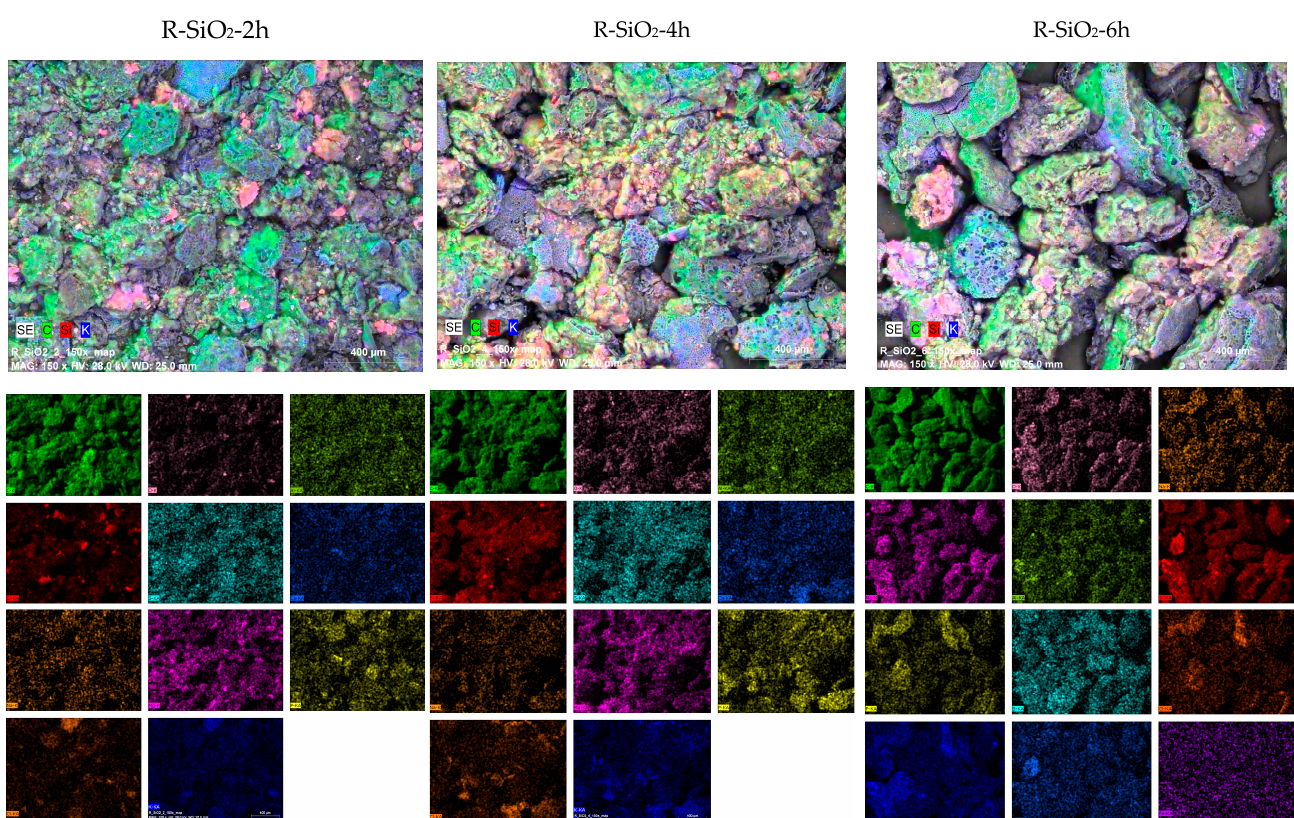
Figure 2. SEM image and mapping results for the biochar–silica composites.